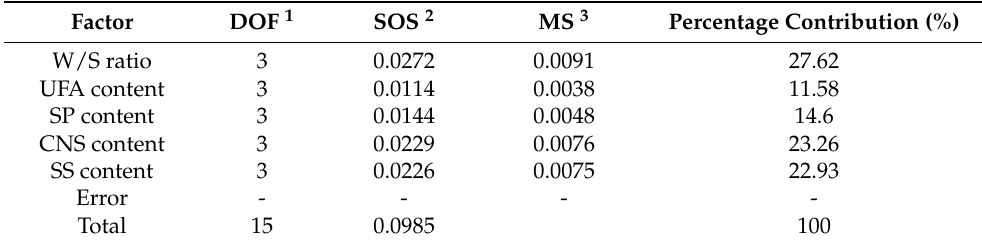
Table 12. ANOVA results of GRG for the factors.